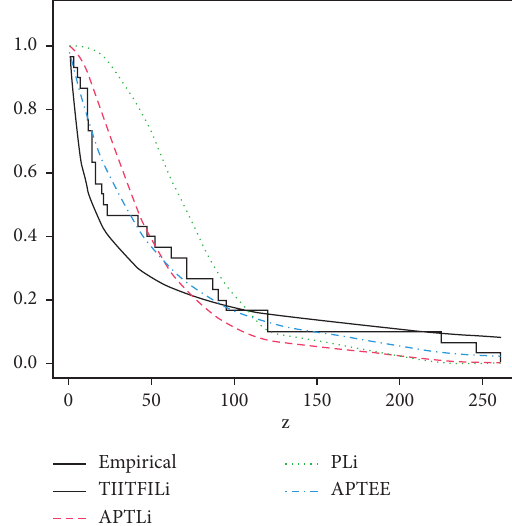
Figure 5: Estimated sf of the TIITFILi and other competing models for the data.